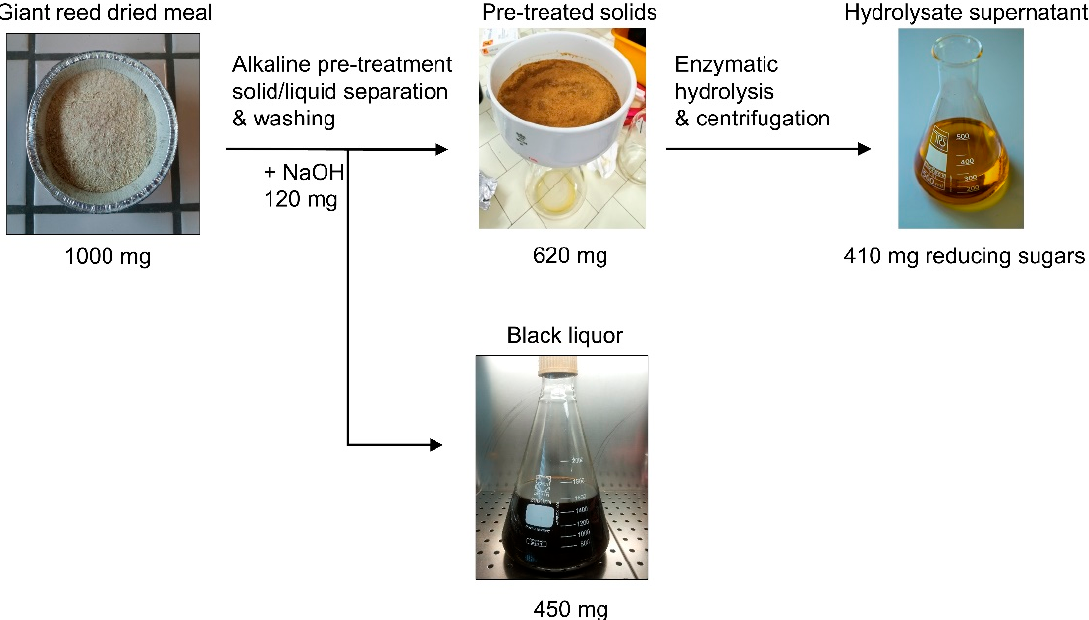
Figure 1. Workflow of the giant reed meal treatment steps, from alkaline pre-treatment to enzymatic hydrolysis. The amounts of the recovered fractions of interest are reported on a dry weight (DW) basis.